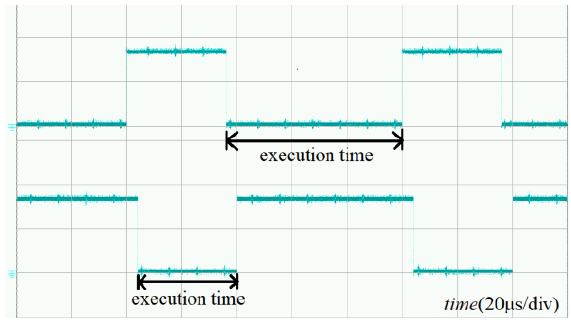
Figure 20. Execution time of the code of the FOC algorithm in the DSP.